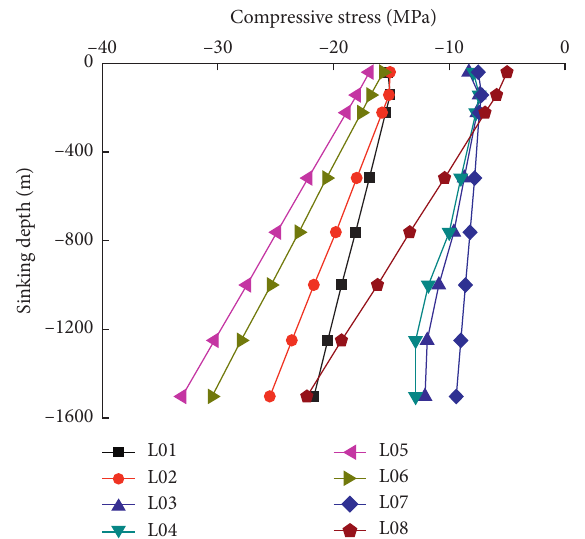
Figure 10: Theoretical stress curves of platform beams of sheave wheel platform under different working